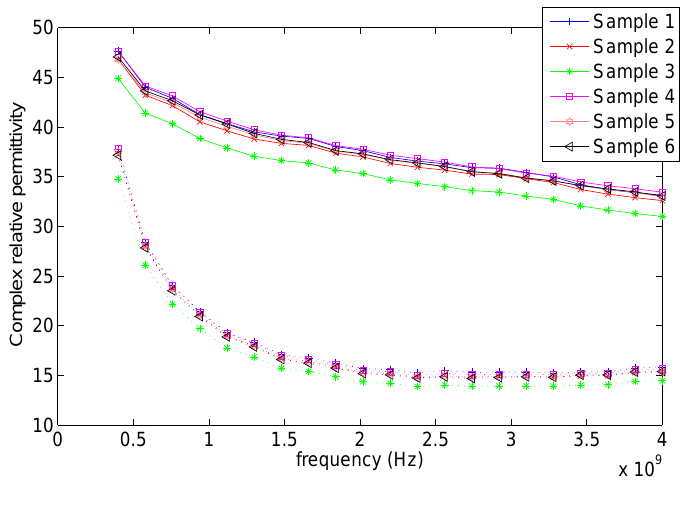
Figure 8. The averaged value of the complex relative permittivity over all samples including standard